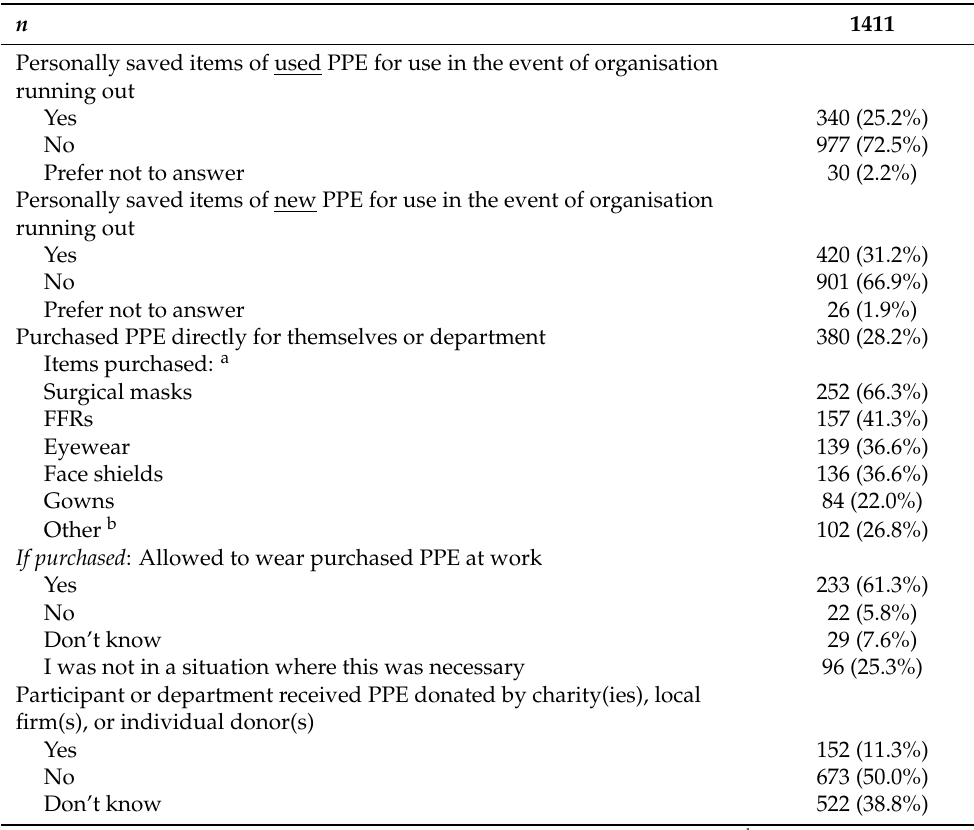
Table 3. Sourcing and procurement of personal protective equipment (PPE) during COVID-19 surge